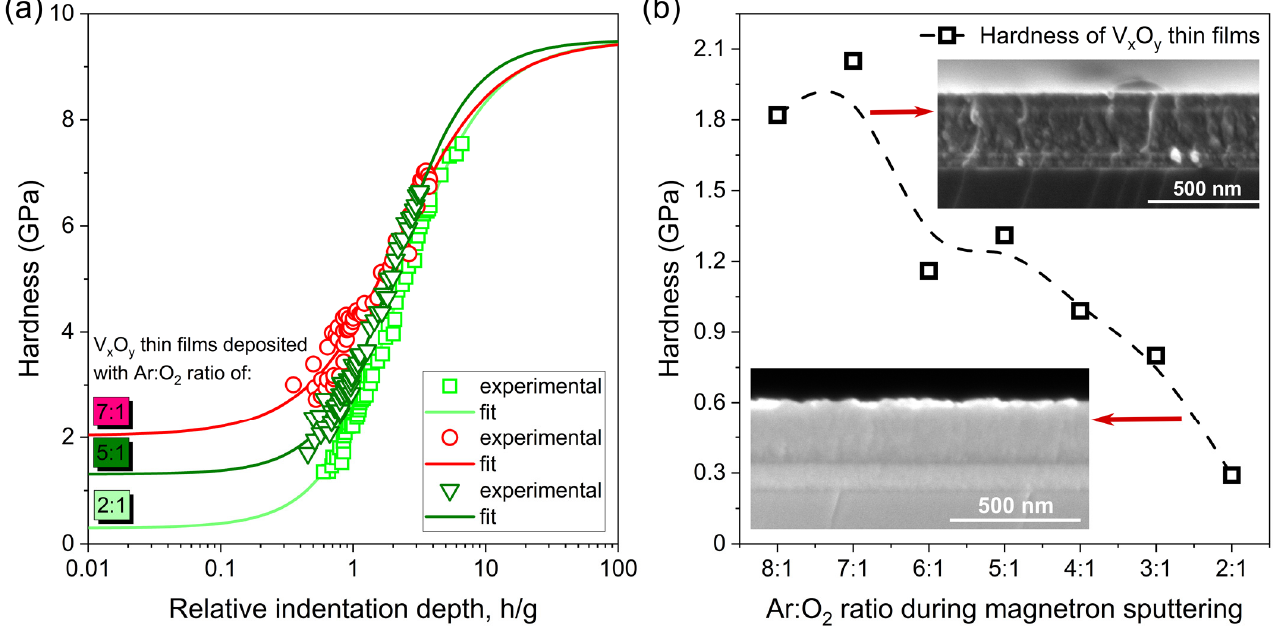
Figure 13. Results of ( a ) the hardness measurement for selected thin films and ( b ) the dependence of hardness of vanadium oxide thin films on the Ar:O 2 gas ratio during the sputtering process.